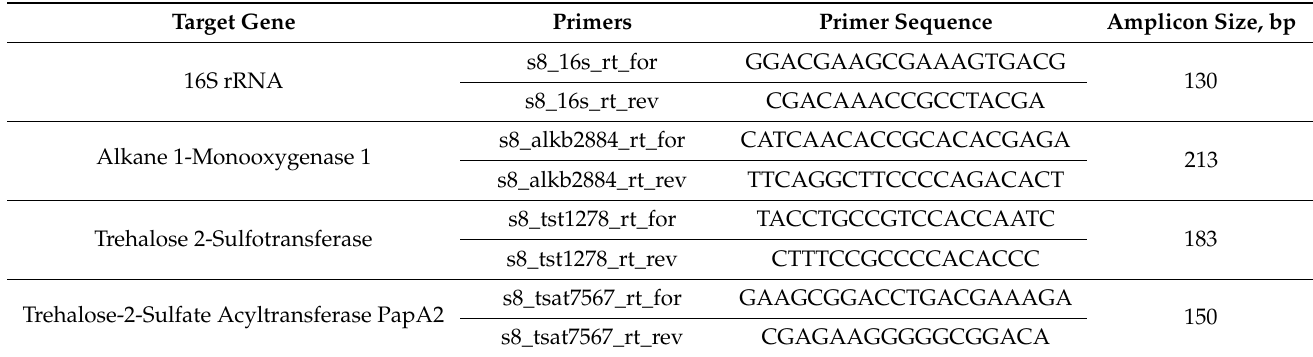
Table 1. Information on primers for genes involved in surfactant biosynthesis in R. opacus S8 strain. Target